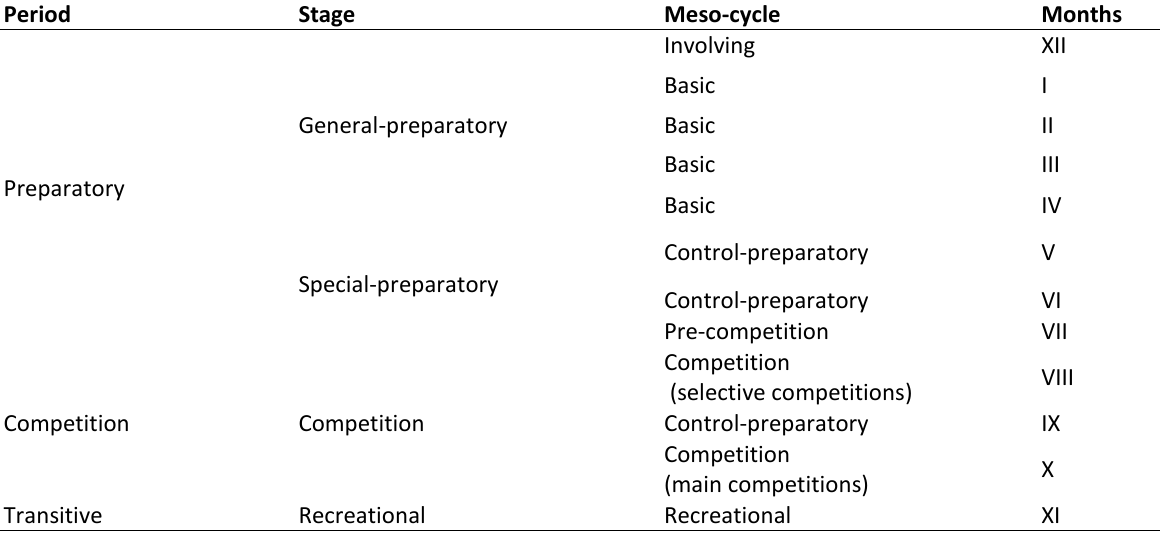
Table 1. Scheme of one-cycle planning in annual training of bodybuilders